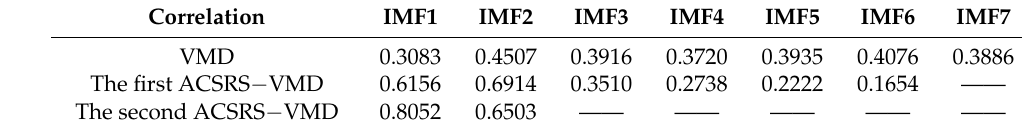
Table 2. Correlation values of different IMF component signals.